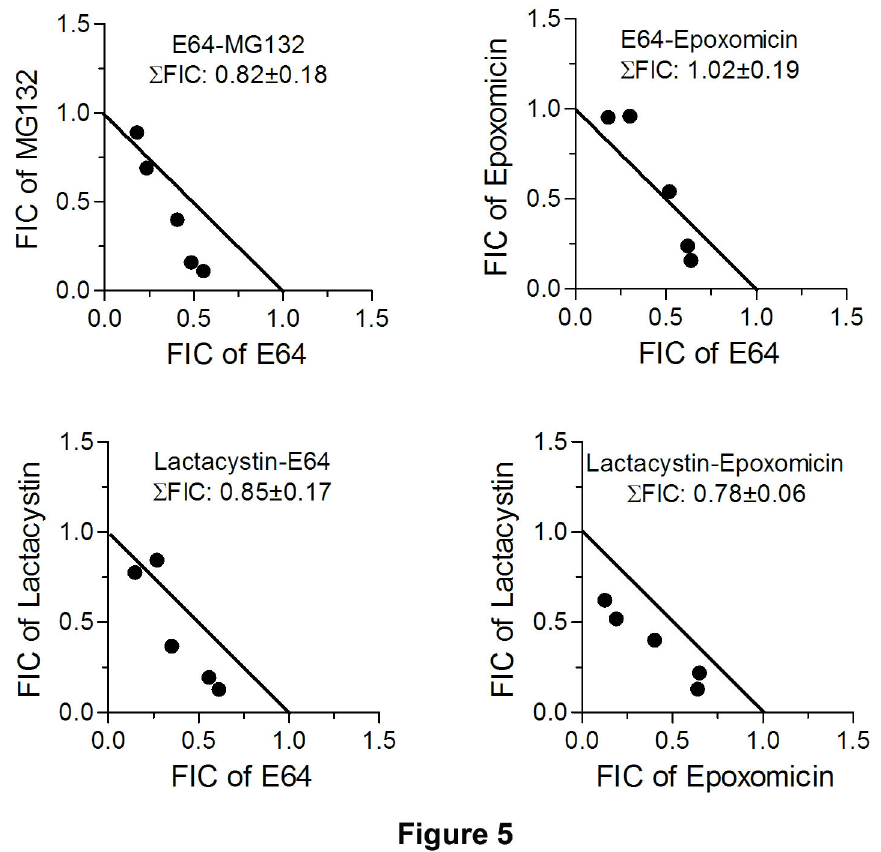
Figure 5. Antimalarial effects of combinations of proteasome and falcipain inhibitors. Parasites were cultured in the presence of varied combinations of the indicated inhibitor, and the 50% inhibitory concentration of each combination was determined to calculate fractional inhibitory concentrations (FIC). FICs from three independent experiments, each carried out in duplicate were used to construct isobolograms as described in Materials and Methods section. Mean FICs (ΣFIC) 0.5-1.0, <0.5, and >1.5 are indicative of additive, synergistic and antagonistic interactions, respectively. A . The isobolograms indicate additive interactions for the indicated combinations.